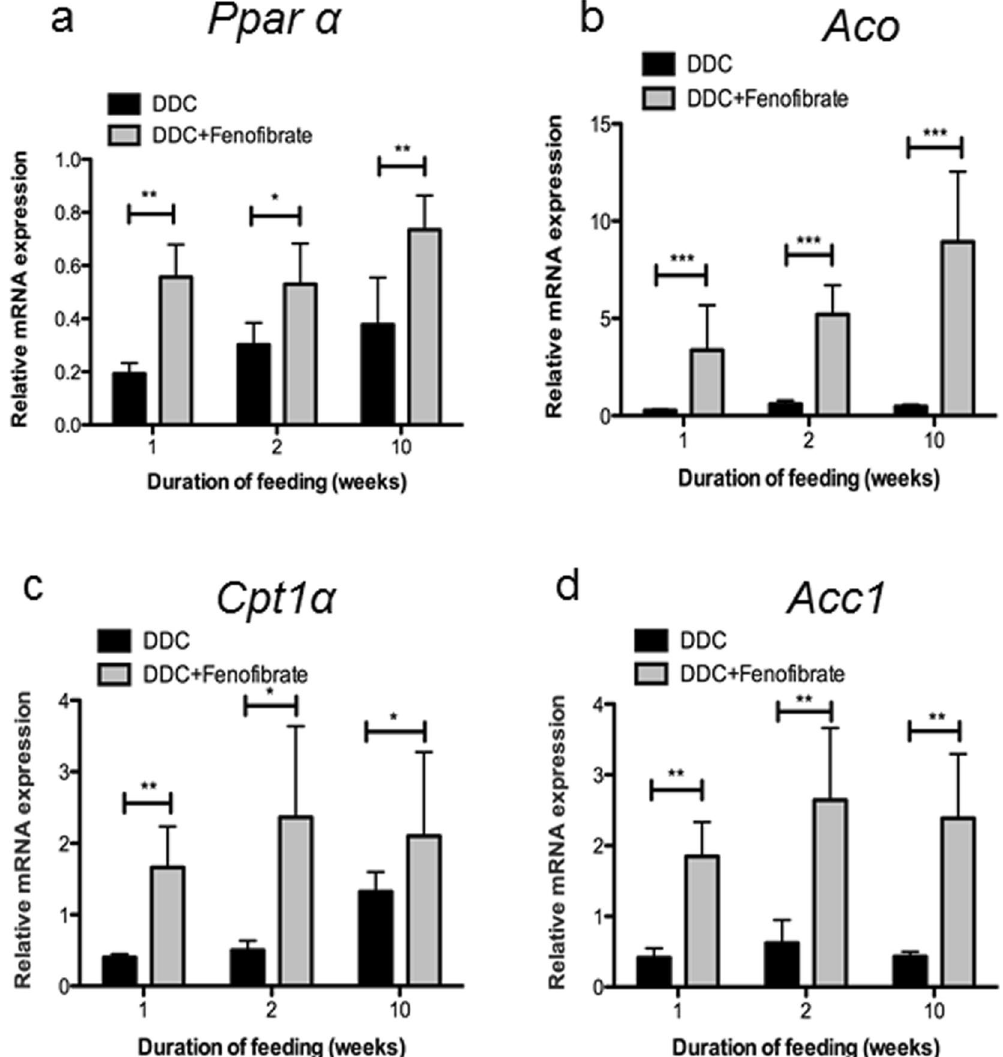
Figure 4. Effect of DDC/fenofibrate co-administration on expression levels of Ppar α and lipid metabolism-related genes. ( a ) Normalized expression levels of Ppar α ; ( b ) acyl-CoA Oxidase ( Aco) ; ( c ) acyl-CoA carboxylase 1 ( Acc1) ; ( d ) carnitine-palmitoyl transferase 1 α ( Cpt1 α ) were evaluated by qRT-PCR of mRNA extracted from whole liver tissue. Data are given as fold-change relative to controls. Significances of DDC intoxication stages are shown versus DDC/fenofibrate co-administration: * p < 0.05; ** p < 0.01; *** p <